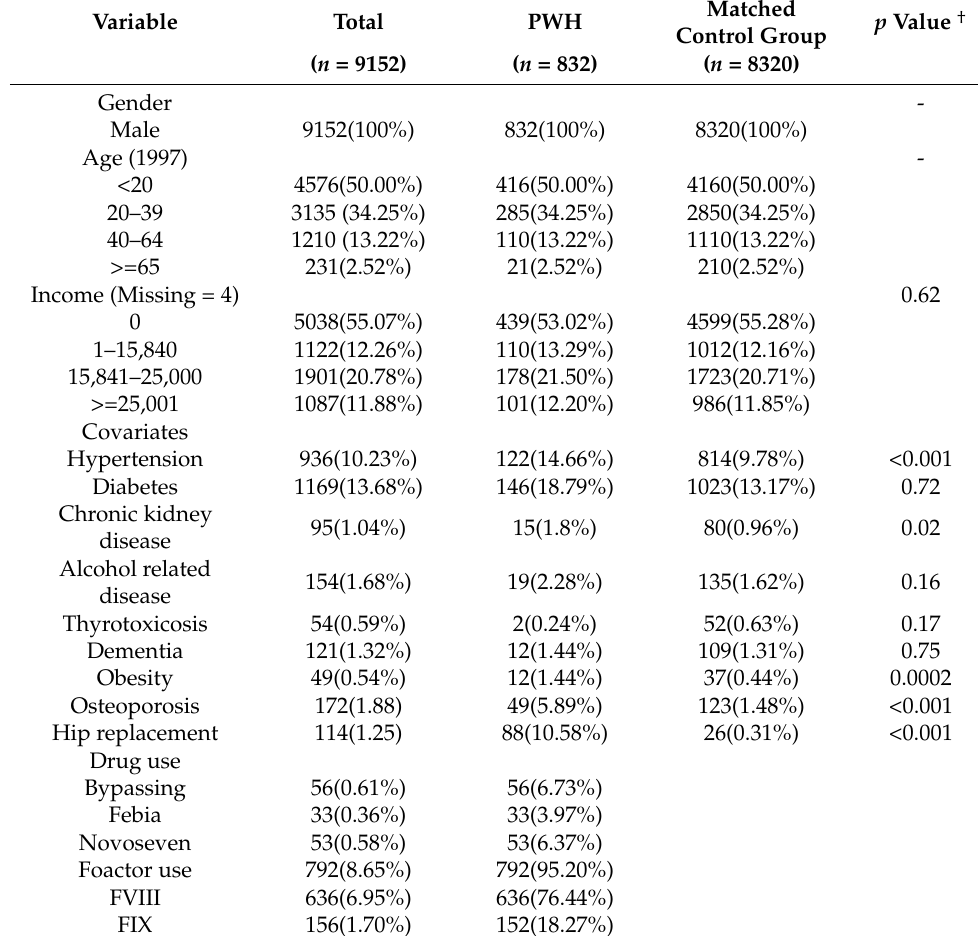
Table 1. Characteristics of patients with hemophilia (PWH) and the matched control group.